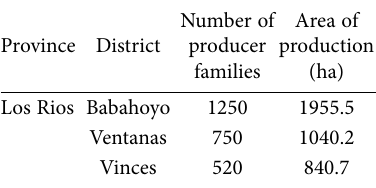
Table 2. Number of producers and cocoa production area.